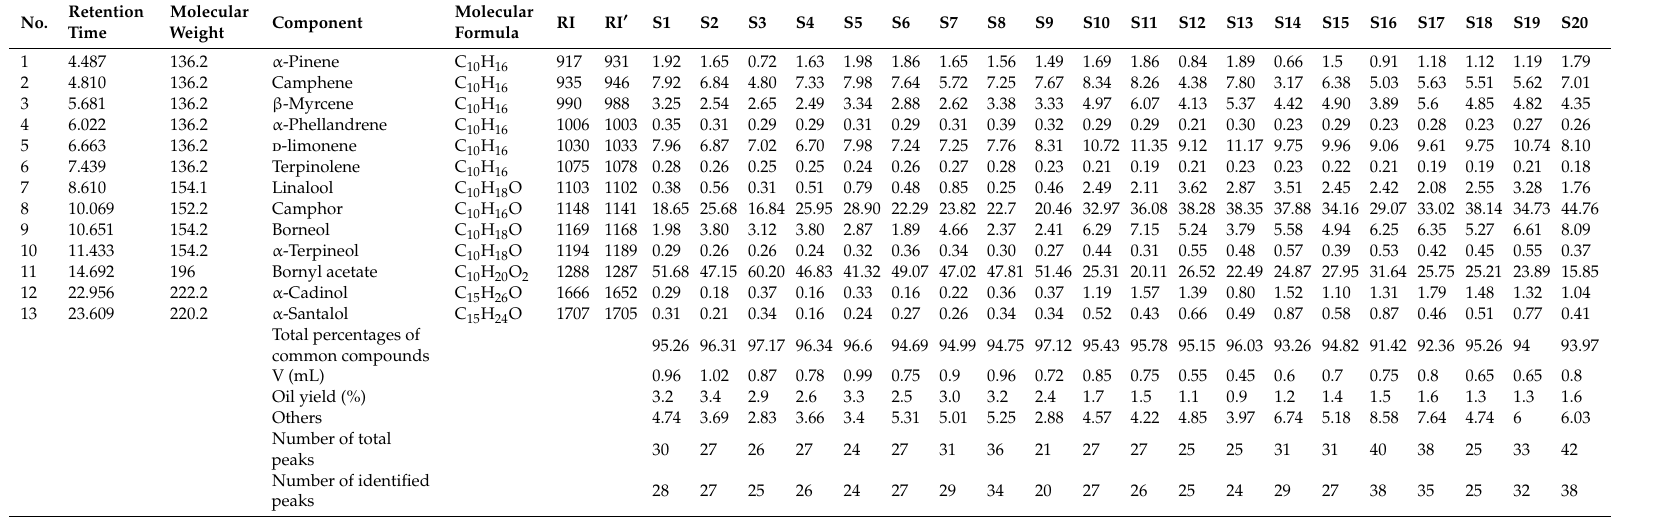
Table 1. The relative contents of the common peaks of Fructus amomi (FA) from the two